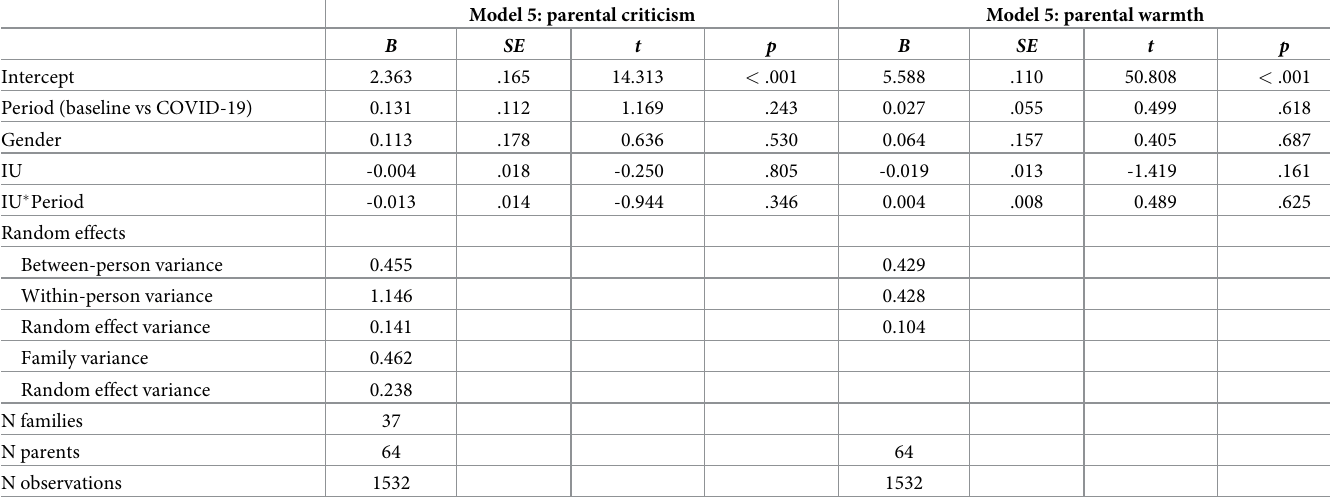
Table 4. Results of final model 5 on the relation between period and daily parenting behavior and the moderating role of intolerance of uncertainty in parents. Model 5: parental criticism Model 5: parental